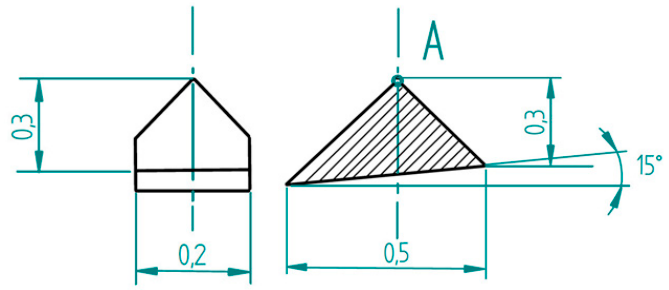
Figure 30. Diamond probing tips with 2 µ m radius and 90 ◦ opening angle.